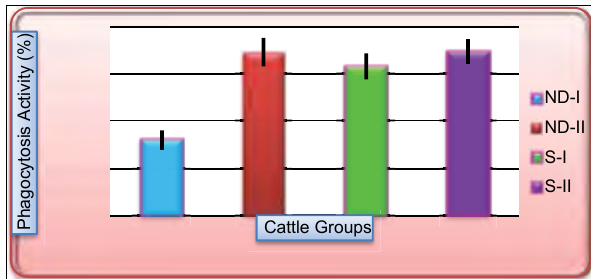
Figure-1: Mean (±standard error) values of phagocytosis activity of non-descript (ND) and Sahiwal cattle, ND-I: ND cattle (6 months-2 years age), ND-II: ND cattle (above 2 years age), S-I: Sahiwal cattle (6 months-2 years age), S-II: Sahiwal cattle (above 2 years age).